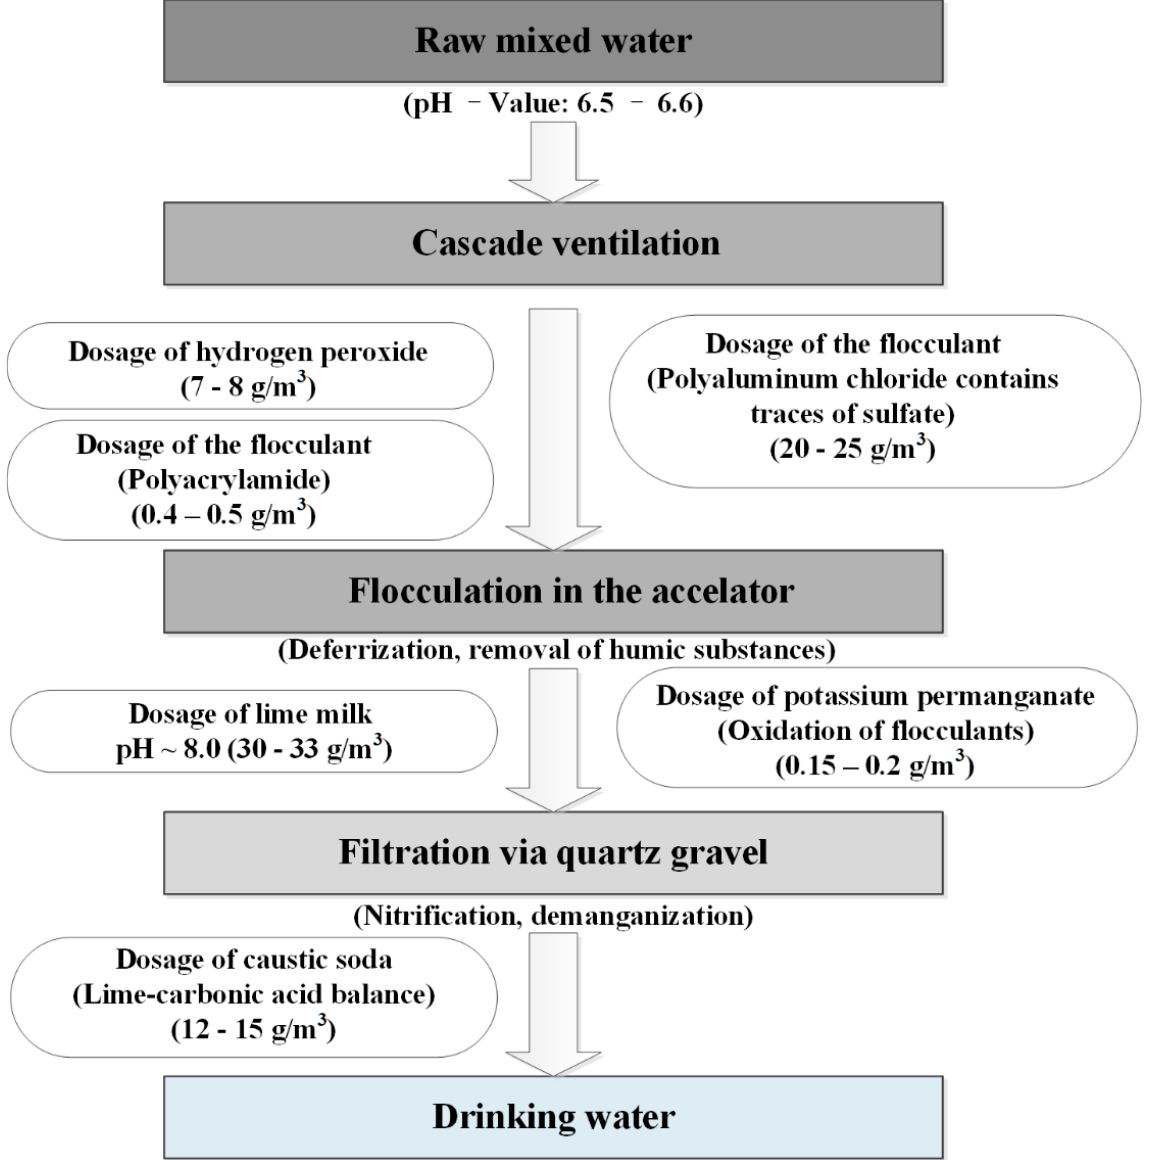
Figure 3. Flowchart of water treatment in the Fuhrberg waterworks.